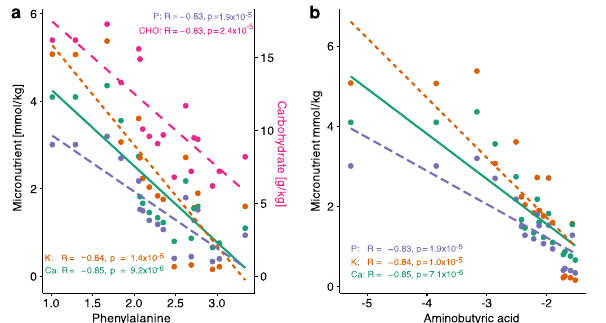
Figure 3. Scatterplots of Pearson correlations of ( a ) phenylalanine with calcium, potassium, phos- phate, and carbohydrate (g/kg) intake levels and ( b ) of ABA with calcium, potassium, and phosphate Nutrients 2022 , 14 , x FOR PEER REVIEW levels. All p -values were significant after FDR.